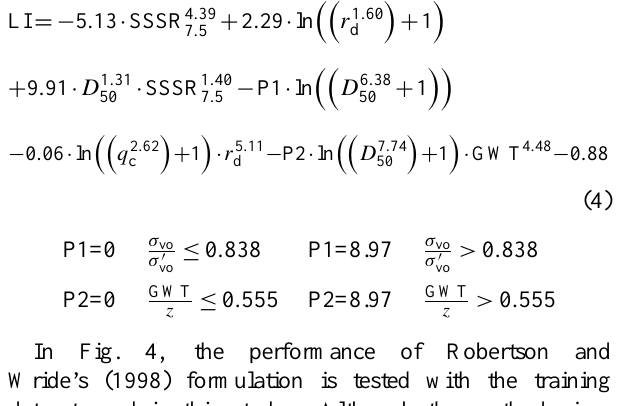
In Fig. 4, the performance of Robertson and Wride’s (1998) formulation is tested with the training dataset used in this